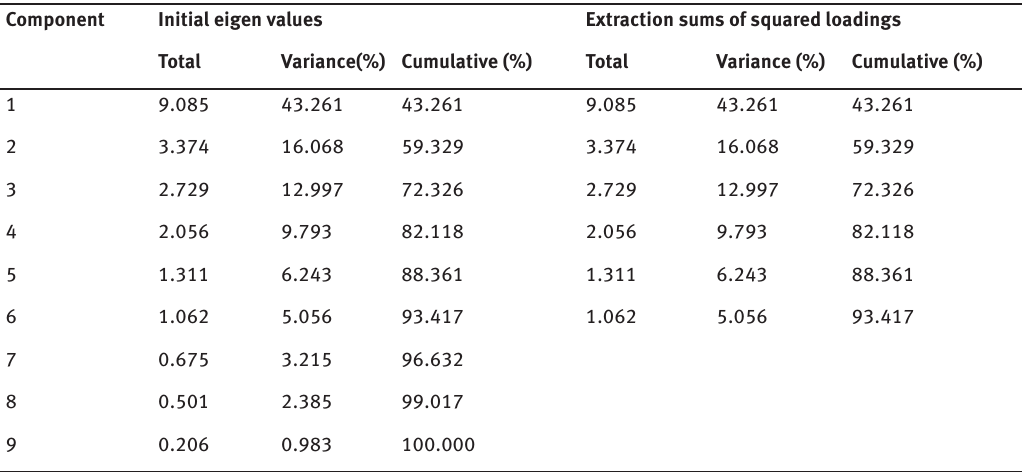
Table 2: Eigen values and corresponding percentages of the variables (top nine principal components)